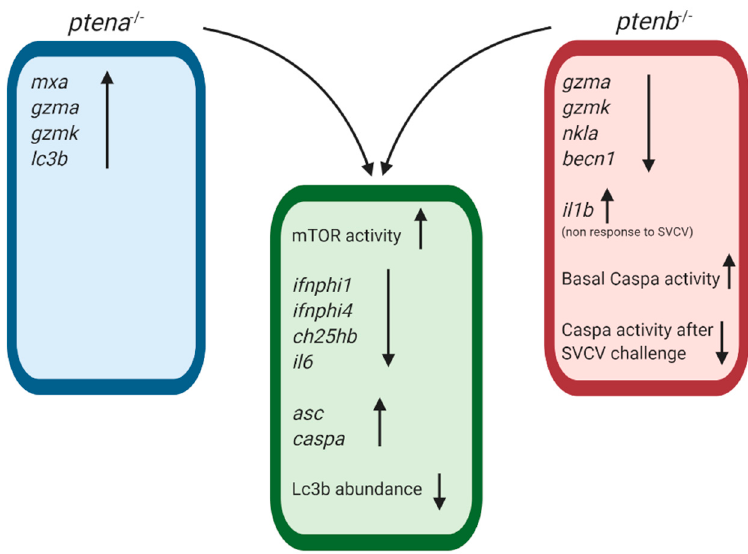
Figure 11. Summary graph representing the common and exclusive modulations observed in the ptena and ptenb mutant zebrafish larvae compared to WT individuals. Arrows up indicate gene overexpression or up-modulated processes compared to WT larvae; arrows down indicate gene expression inhibition or down-regulated processes compared to WT larvae.